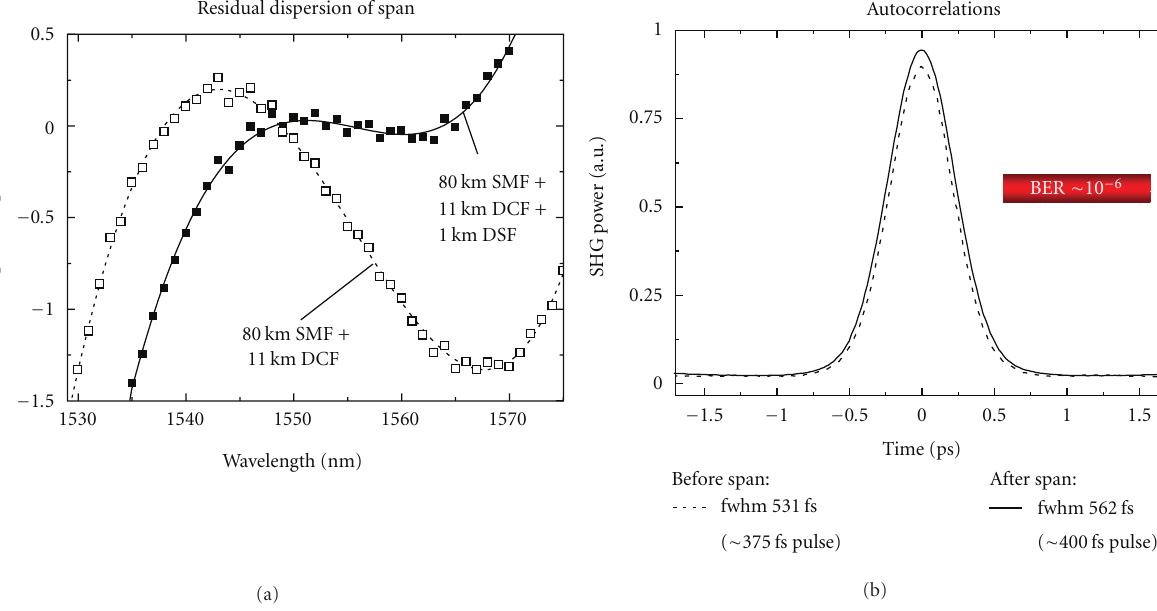
Figure 9: Preliminary transmission results. The stated “fwhm” pulse widths are autocorrelation measurements. The deconvoluted FWHM pulse widths are in brackets (375/400fs).